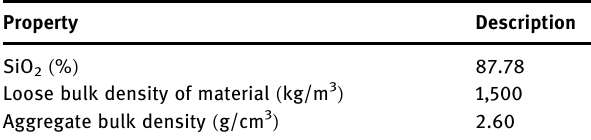
Table 1: The properties of the natural aggregate